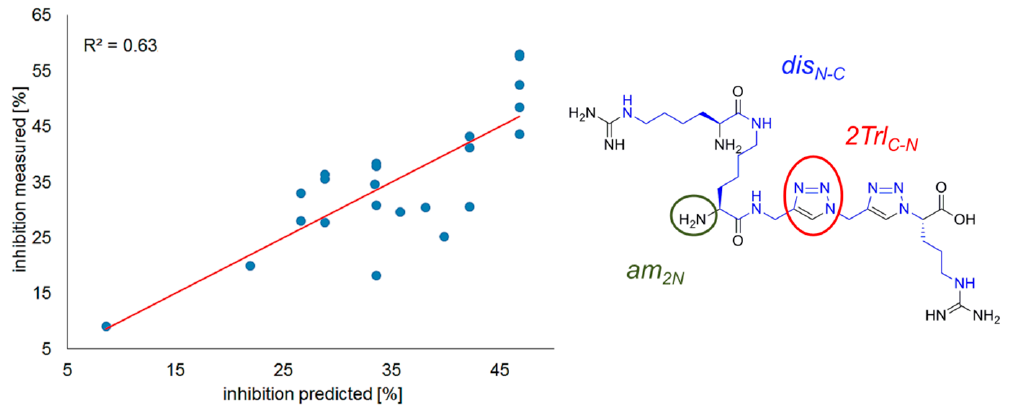
Figure 5. Correlation of observed vs. predicted (Model 2) inhibitory activity with marked variables.